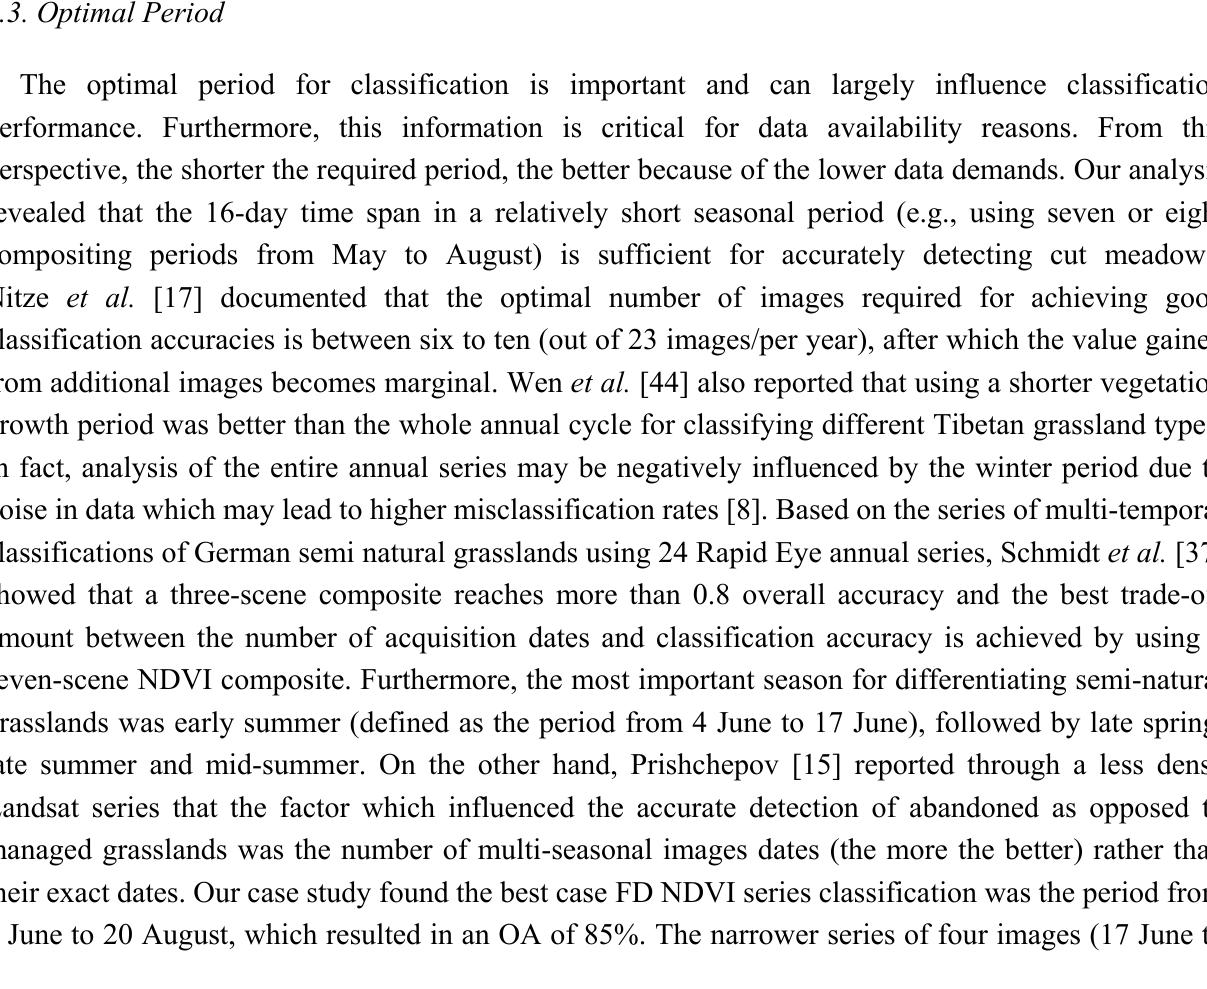
Number of Rules